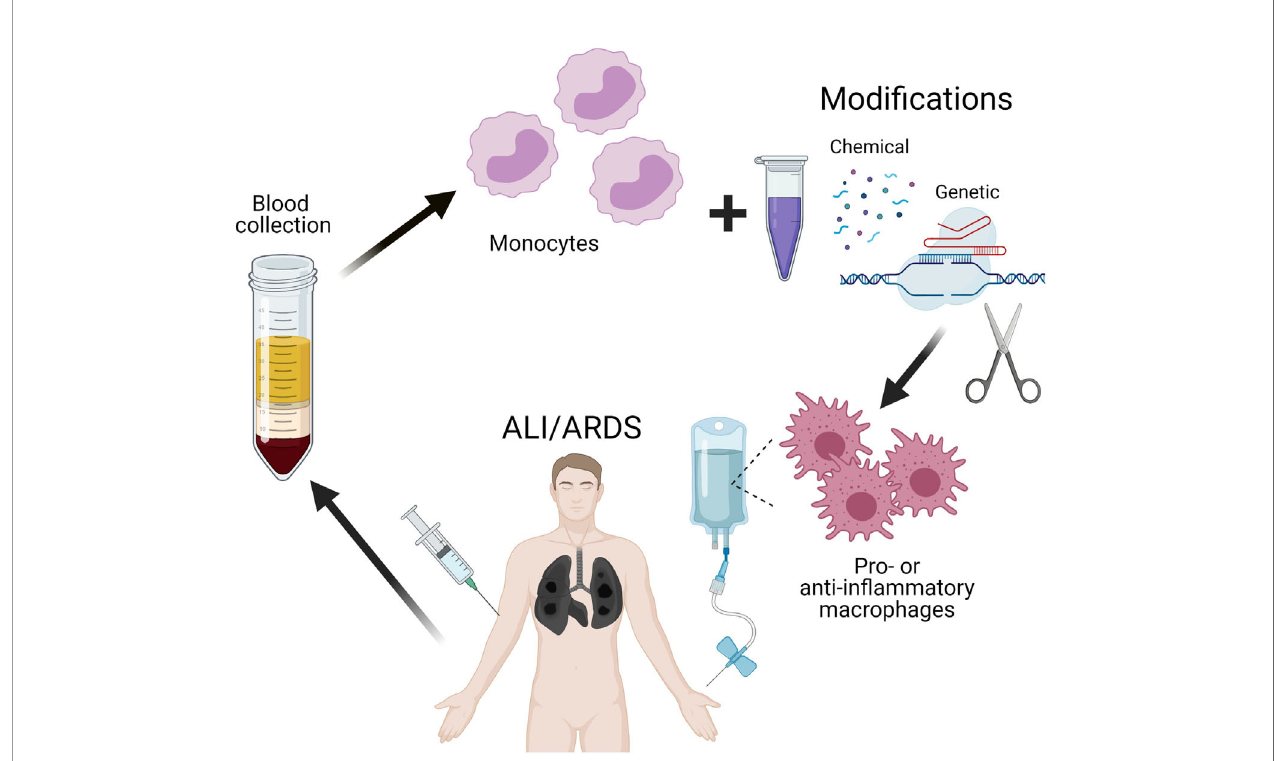
FIGURE 2 | Scheme of perspective therapy of ALI/ARDS by reprogramming of